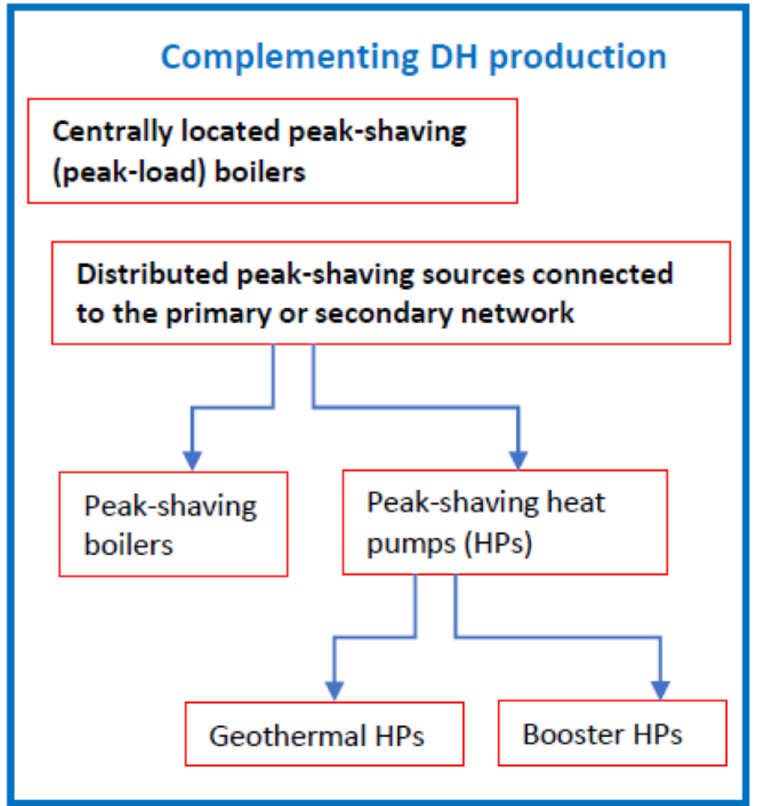
Figure 4. Proposed categorization of the complementing DH production sources that manage DH load variations.